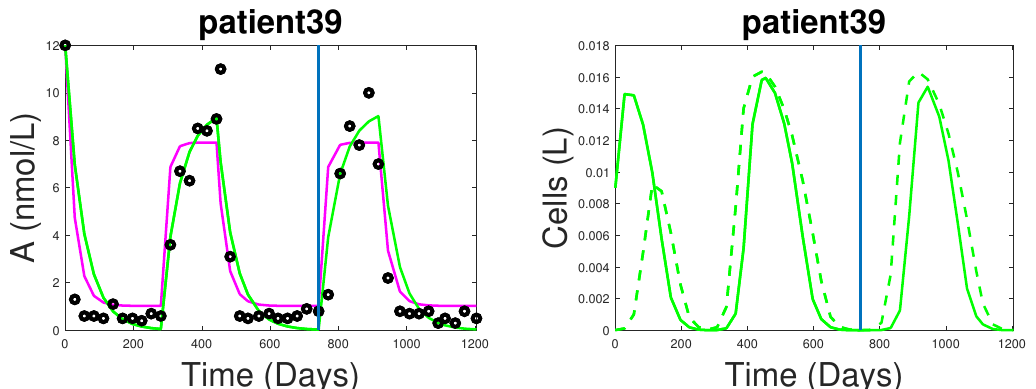
Figure 2. (1) The left figure shows the fitting and forecasting of serum androgen for the BK model (magenta) and the new model (green). The blue line divides the fitting the forecasting periods. (2) The right figure shows the cancer cell dynamics, over the course of 2.5 cycles. The solid green curve represents the AD cell subpopulation, while the dashed green curve represents the AI cell subpopulation.